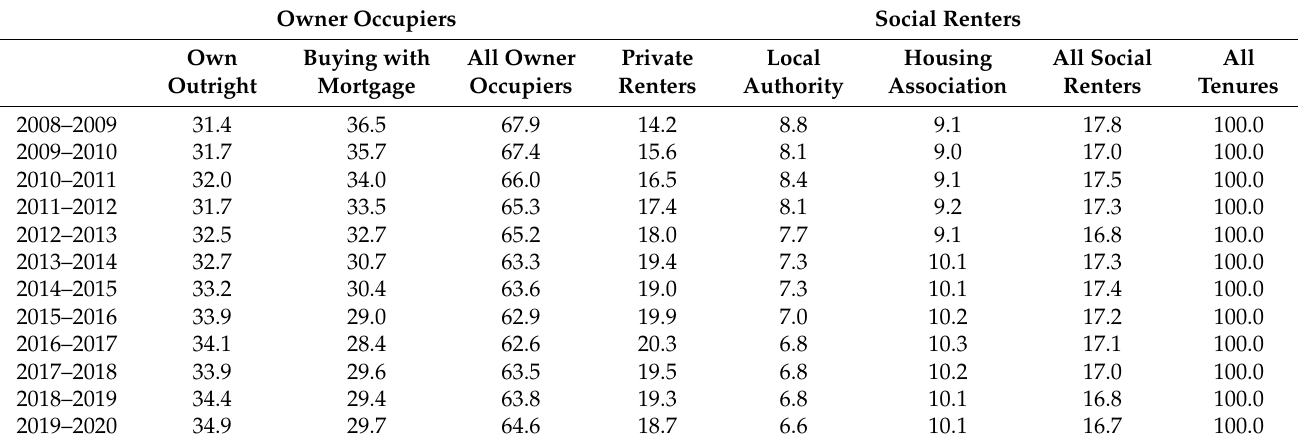
Table A1. Trends in tenure, 1980 to 2019–2020